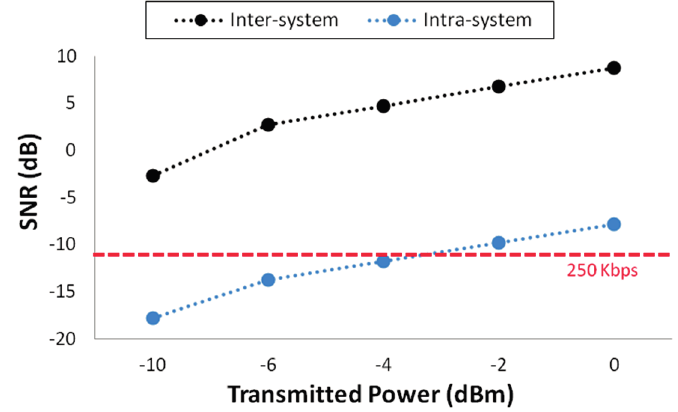
Figure 9. Estimated inter-system and intra-system SNR values for antenna